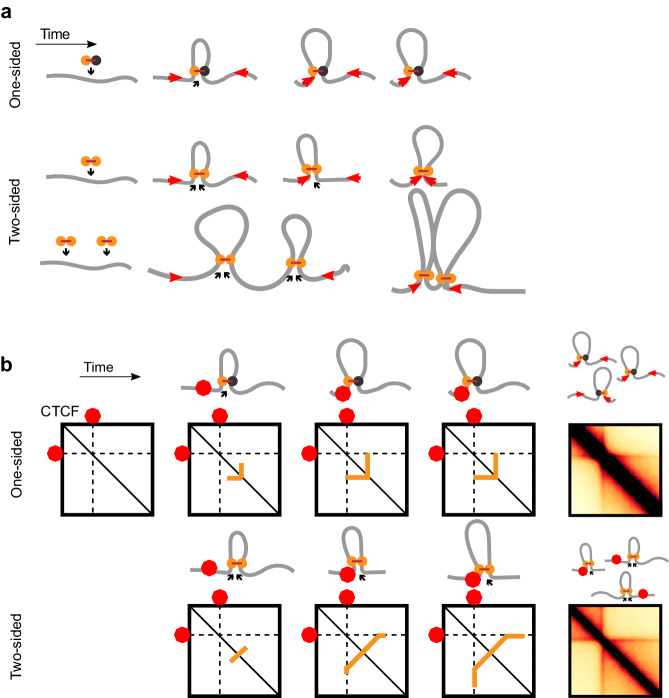
Illustrations of loop extrusion by one-sided and two-sided LEFs.(a) One-sided LEFs leave a gap between the passive LEF subunit and a barrier, unless they are loaded at a barrier (top row). Two-sided LEFs, on the other hand, can pair barriers while loading between barriers in two possible ways; a single two-sided LEF can pair two barriers (middle row), or barriers can be paired through the collective extrusion of multiple LEFs (bottom row). (b) Illustration of stripe formation by one- and two-sided LEFs.